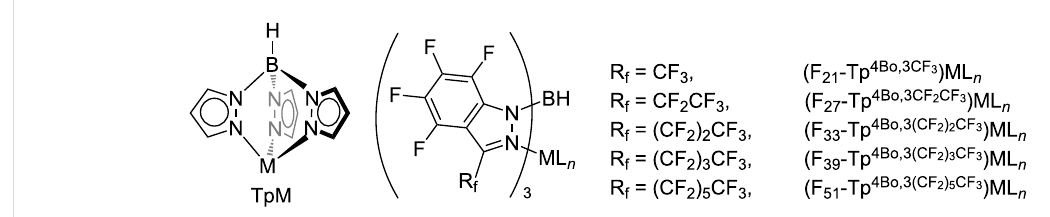
Figure 1: The structure of TpM catalysts.